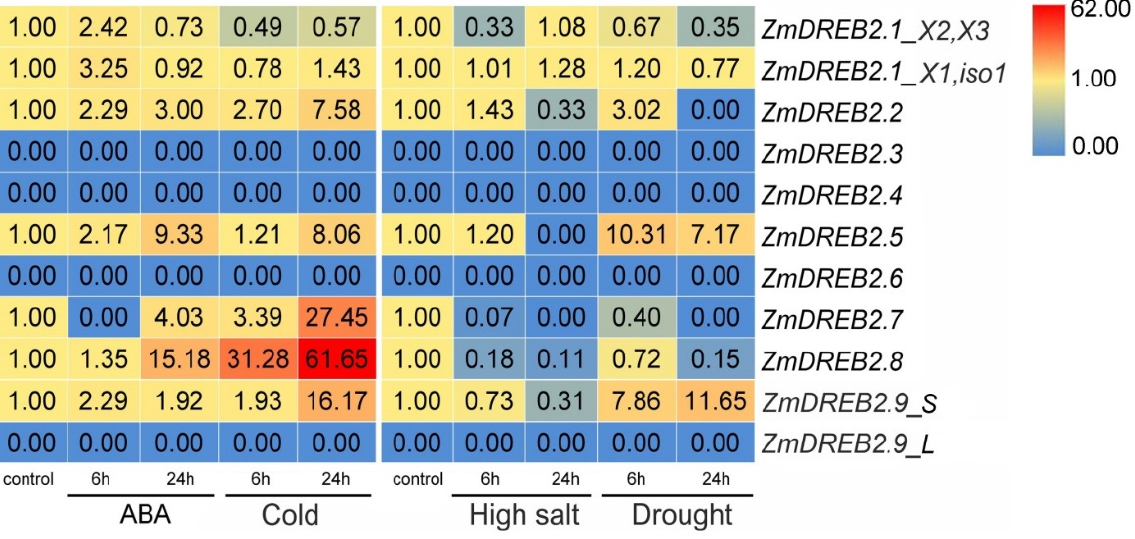
Figure 4. Heatmap of ZmDREB2.1/2A–2.9 time-dependent expression in Z. mays cv. B73 seedlings subjected to cold, high salt, and drought stresses and ABA treatment. The data were normalized to ZmUBC expression. The color gradient indicates expression changes from low (blue) to high (red).